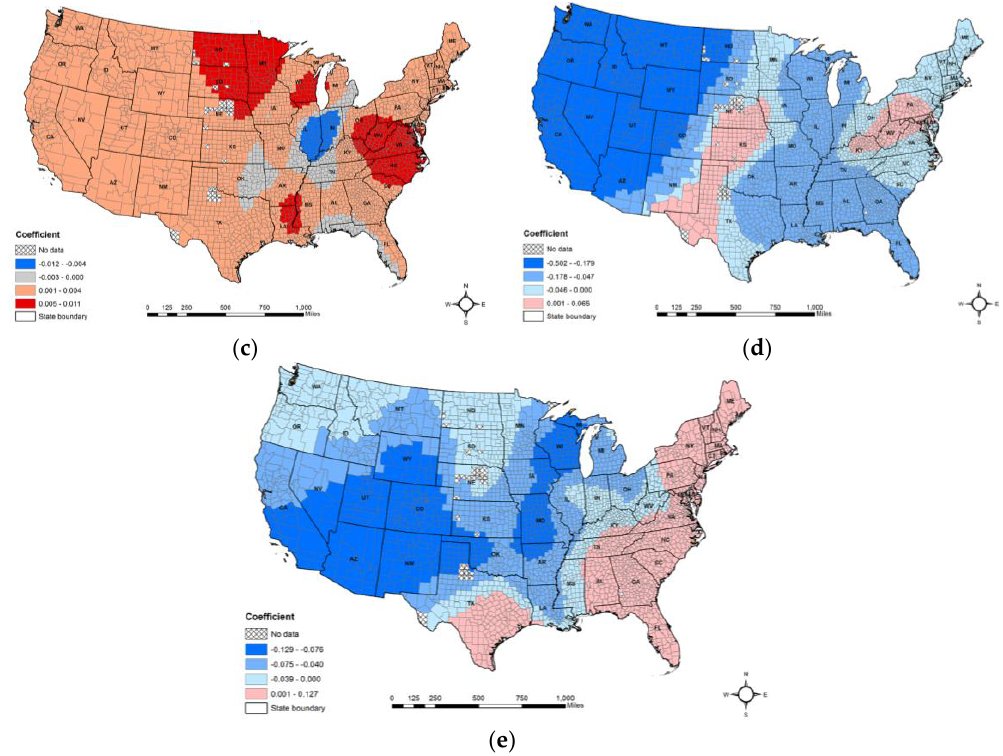
Figure 5. Coefficient estimates of the GWR model: ( a ) percentage of the local population that smoke; ( b ) percentage of the population aged 65 and above; ( c ) mean county altitude; ( d ) percentage of the African American population; and ( e ) the association rate.